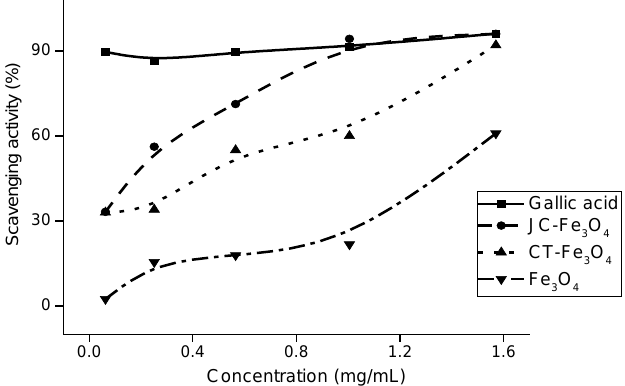
Figure 12. DPPH scavenging activity (%) of MNPs and standard gallic acid solution.